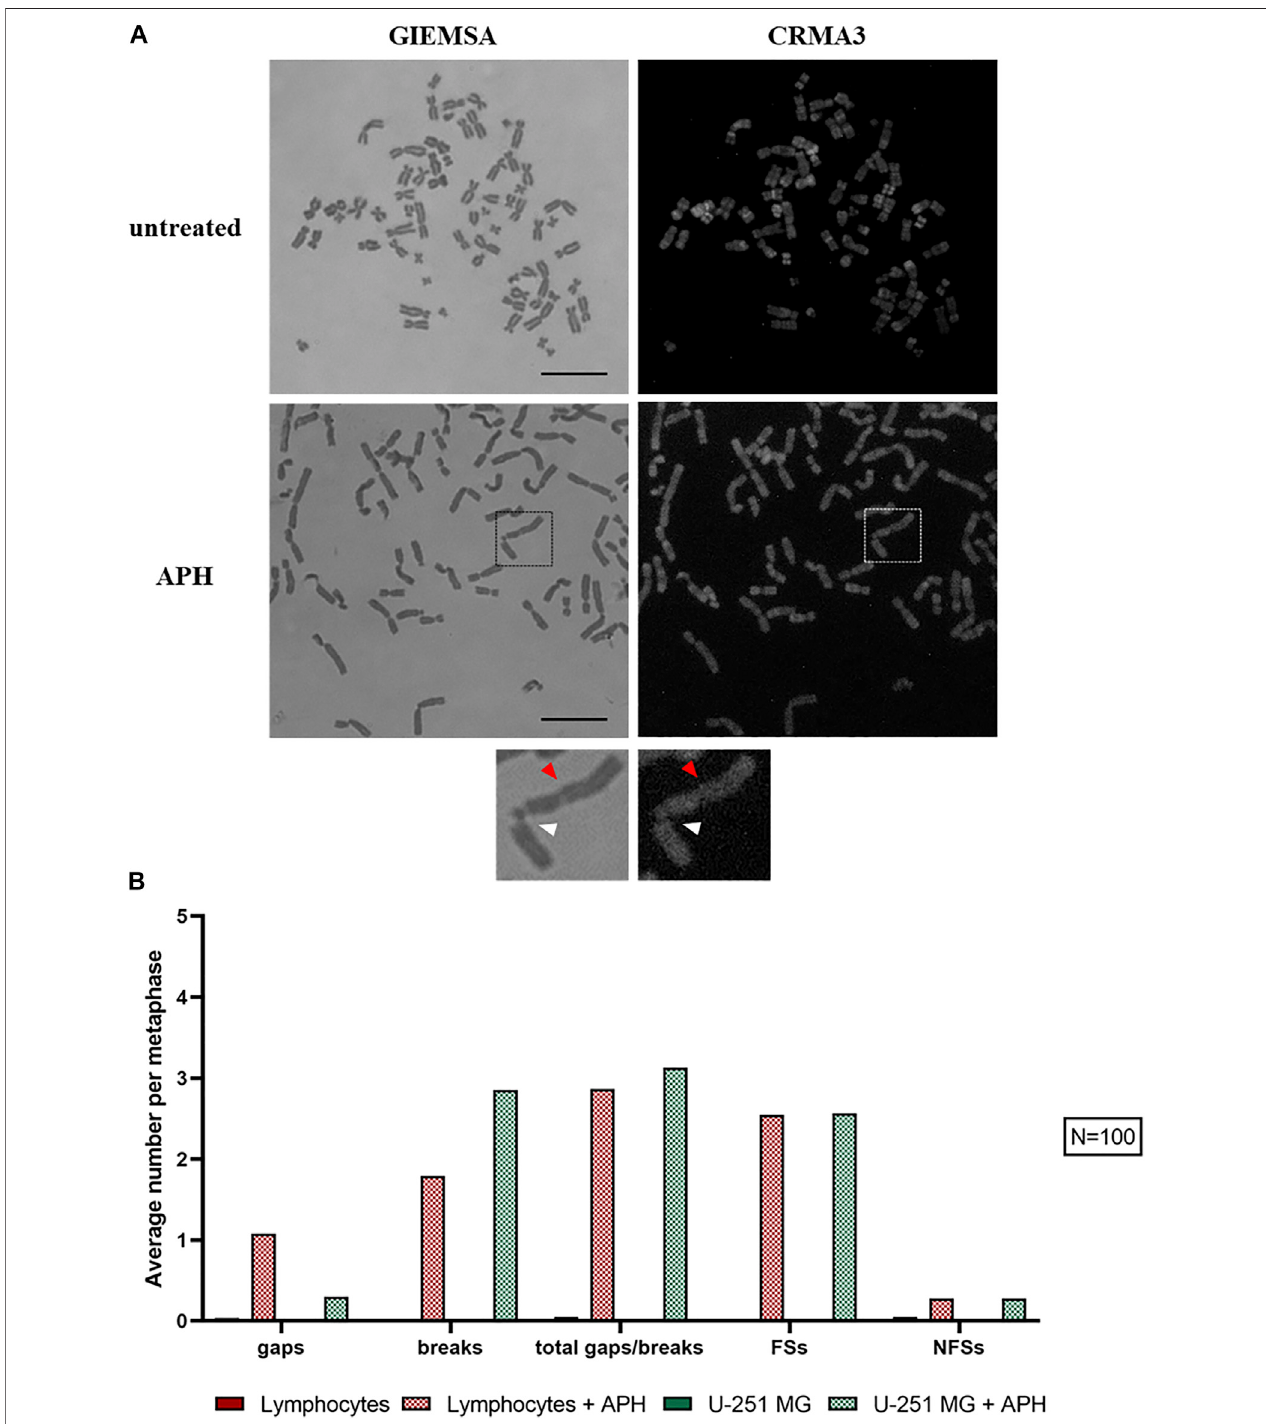
FIGURE 4 | U-251 MG metaphases stained with Giemsa and CRMA3 in control and APH-treated conditions; the brackets highlight chromosome 2, where white arrowsindicatethebreakwithinFRA2E(2p12/13)andredarrowsthegapwithinFRA2F(2q22) (A) .Thegraphshowstheaveragenumberofgaps/breakspermetaphase under both conditions and how many of these lesions were fragile sites (FSs) or non-fragile sites (NFSs) (B) . Number of counted metaphases under control and APH- treated conditions was 100 ( N (cid:1) 100) for one replicate. Scale bar: 10 µm.